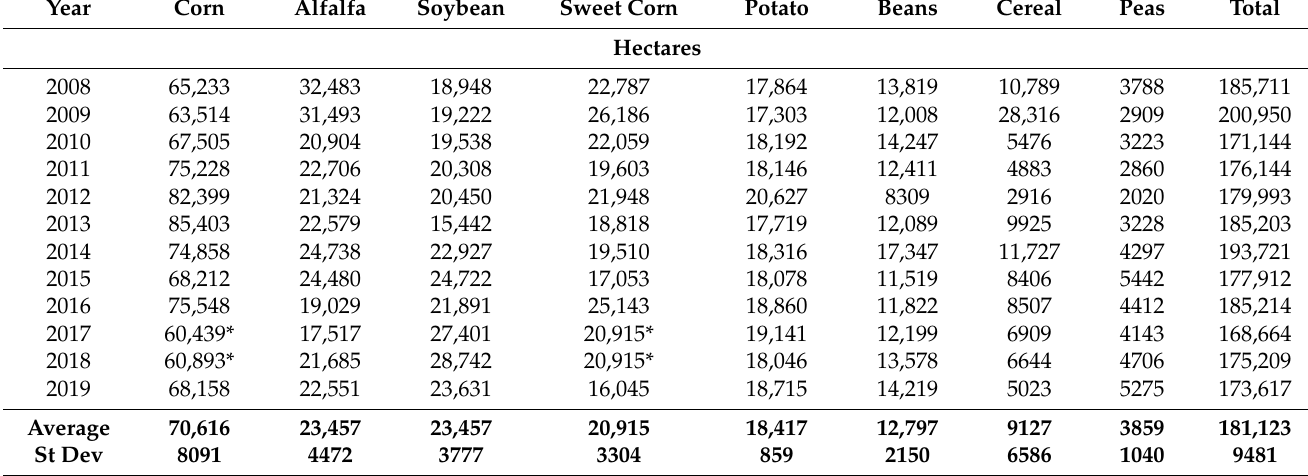
Table 1. Total number of hectares for the eight main crop categories grown in the WCS from 2008 to 2019, their average hectare totals for each year, and standard deviations. In 2017 and 2018, sweet corn was misclassified in the USDA CDL as part of the corn category. The table reflects adjusted values for sweet corn and corn in each of those years (denoted with an asterisk), where the sweet corn annual average number of hectares for all other years (2008–2016, 2019) was used as a substitute in 2017–2018, and that value was subtracted from the corn